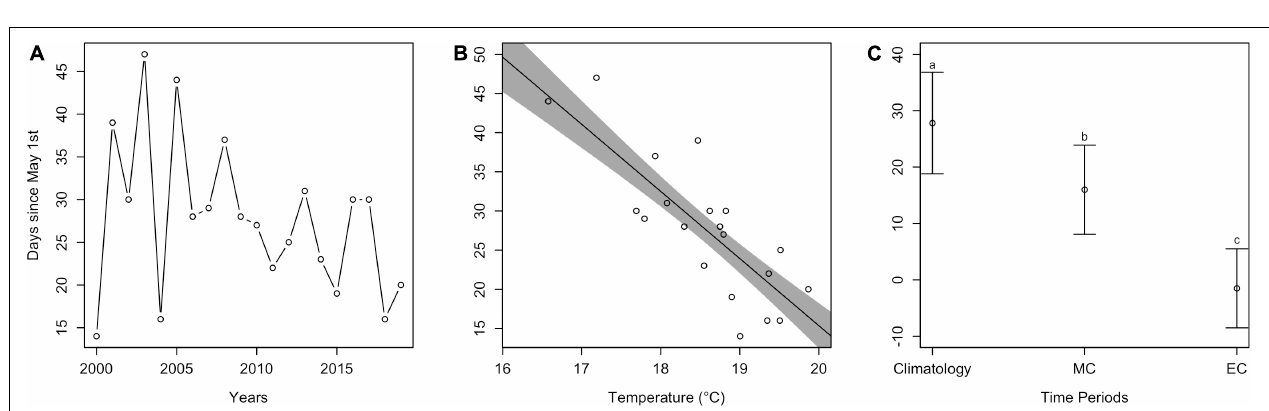
FIGURE 3 | Depth weighting factors for each 3 m depth bin for each arrival month (May and June), departure month (August and September), and all summer months combined (May–September).